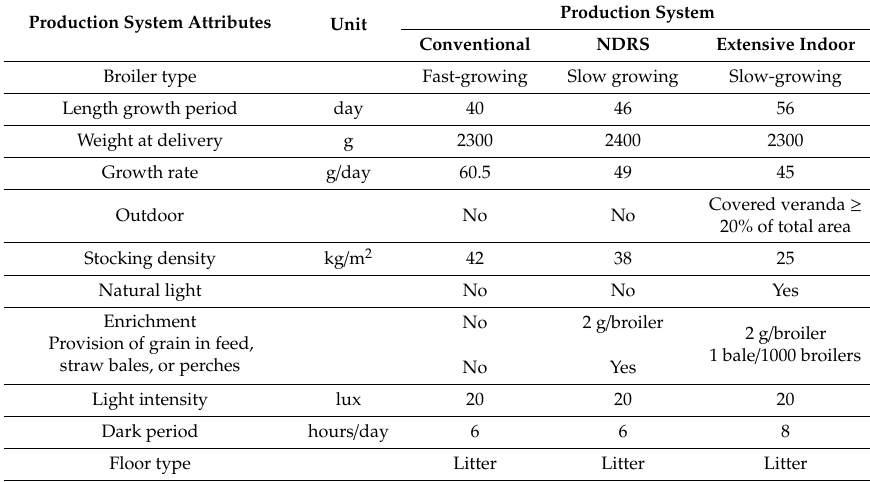
NDRS: new Dutch retail